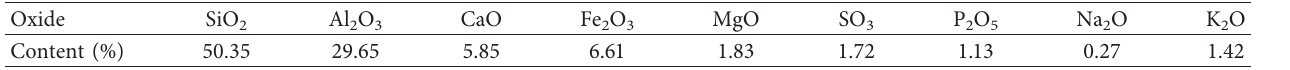
Table 1: Chemical composition of fly ash.